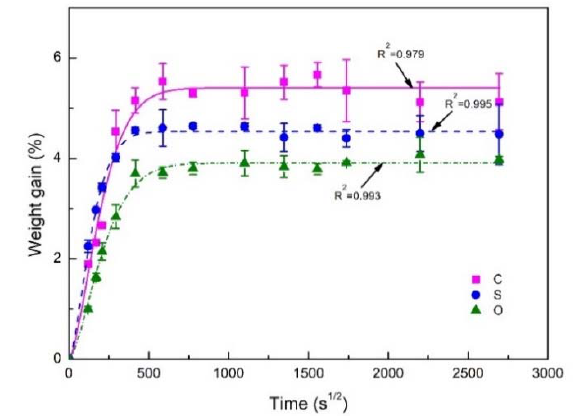
Figure 4. Water absorption process of FFRPs at 70 °C under 80% RH. (C: untreated FFRPs; S: silane coupling agent treated FFRPs; O: nano-clay grafted FFRPs).